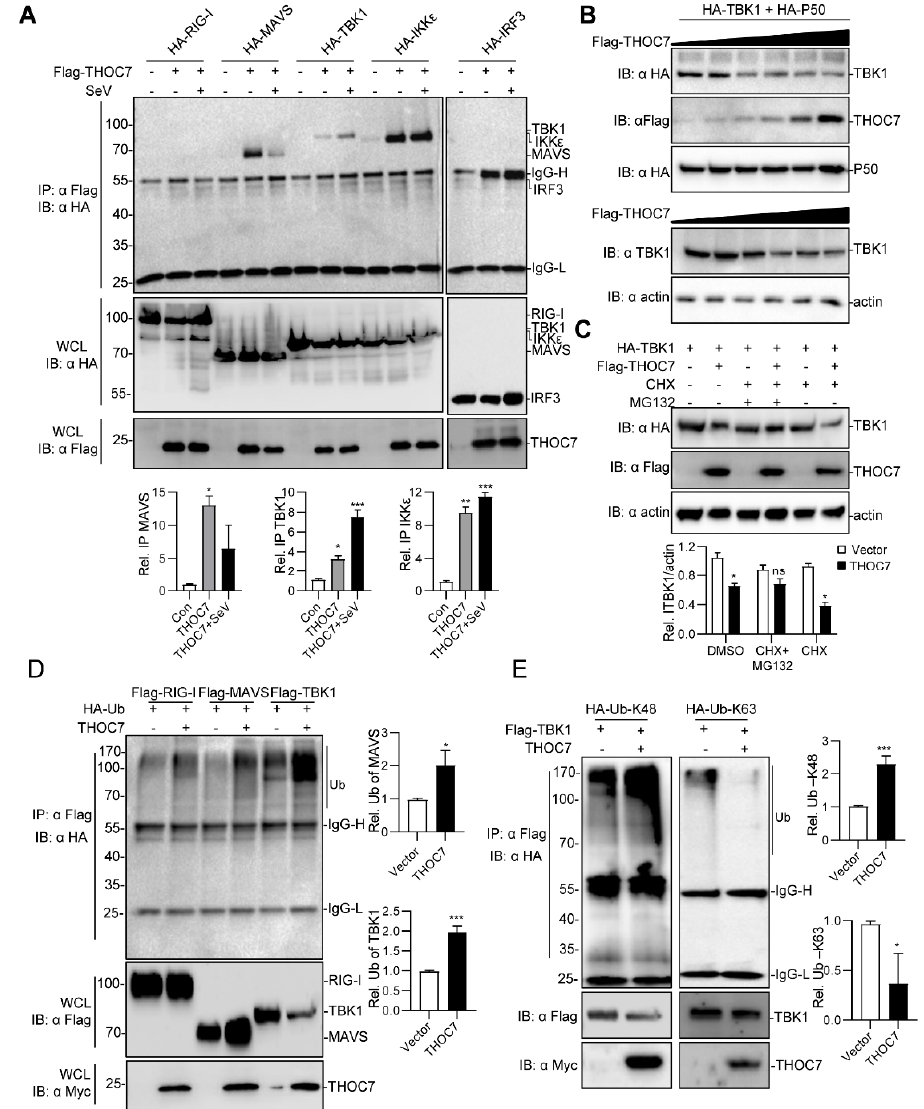
Figure 4. THOC7 is involved in the (mitochondrial antiviral signaling (MAVS) signalosome and drives proteasomal degradation of TBK1. ( A ) THOC7 was involved in forming the MAVS signaling complex. 293T cells were seeded into 100-mm dishes and transfected with Flag-tagged THOC7 or empty control plasmids (10 µ g) and HA-tagged RLR signaling molecules (10 µ g) as indicated. After 12 h of transfection, the cells were treated with or without SeV for 12 h. Co-immunoprecipitation and immunoblot analysis was performed with the indicated antibodies. ( B ) THOC7 promoted degradation of exogenous and endogenous TBK1 in a dose-dependent manner. 293T cells were seeded into 6-well plates and transfected with increasing amounts of Flag-THOC7 (0, 0.1, 0.2, 0.4, 0.8, 1.2 µ g), and HA-TBK1 (2 µ g). Twenty-four hours after transfection, immunoblot analysis was performed with the indicated antibodies. ( C ) MG132 restored the TBK1 protein level in the presence of THOC7. 293T cells were seeded into 6-well plates and transfected with Flag-THOC7 (2 µ g) and HA-TBK1 (1.5 µ g). MG132 and CHX were added after 6 h of transfection and the cells were harvested for analysis after 24 h. ( D , E ) THOC7 increased the K48-linked ubiquitination of TBK1. 293T cells were seeded into 100-mm dishes and transfected with the indicated plasmids (8 µ g each). Similar co-immunoprecipitation and immunoblotting experiments were performed with the indicated antibodies. Quantification of western blotting bands ( A , C , E , F ) from three independent experiments was performed with Image J software. Error bars indicate SD. n = 3. *, p < 0.05; **, p < 0.01; ***, p < 0.001; ns, no significant difference.